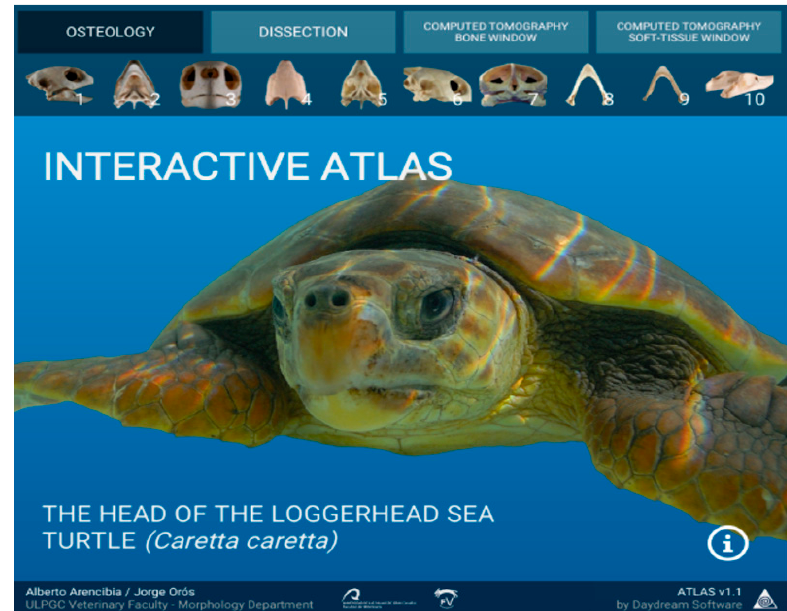
Figure 2. The menu navigation bar is shown for all sections of the atlas.